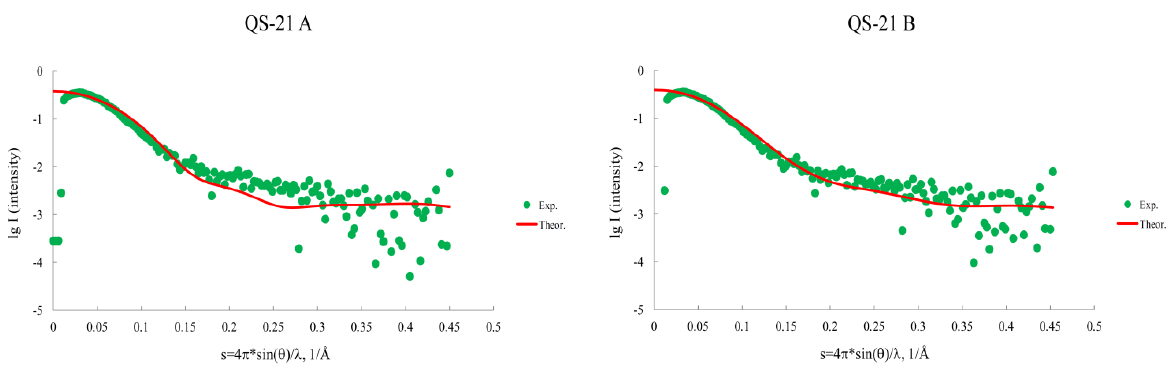
Figure 9. Comparison between data obtained by computational simulations and SAXS. The experimental curve (green symbols) is fitted to the theoretical curve (red line), using CRYSOL server and the final micelle model obtained in the simulation.